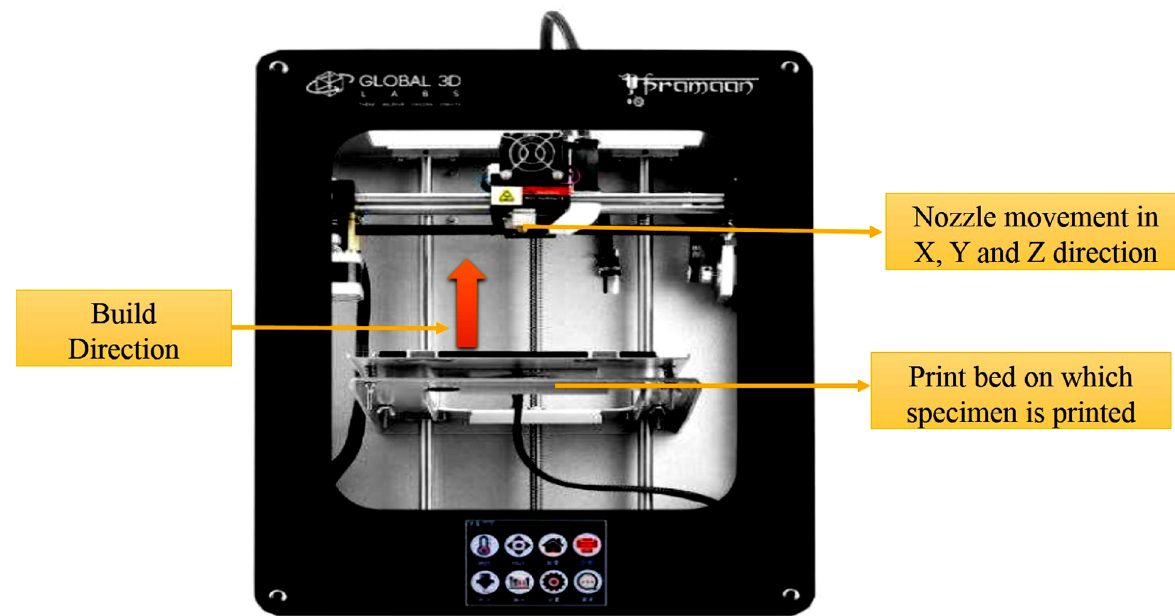
Figure 4. Photograph of FDM machine used for fabrication of parts.